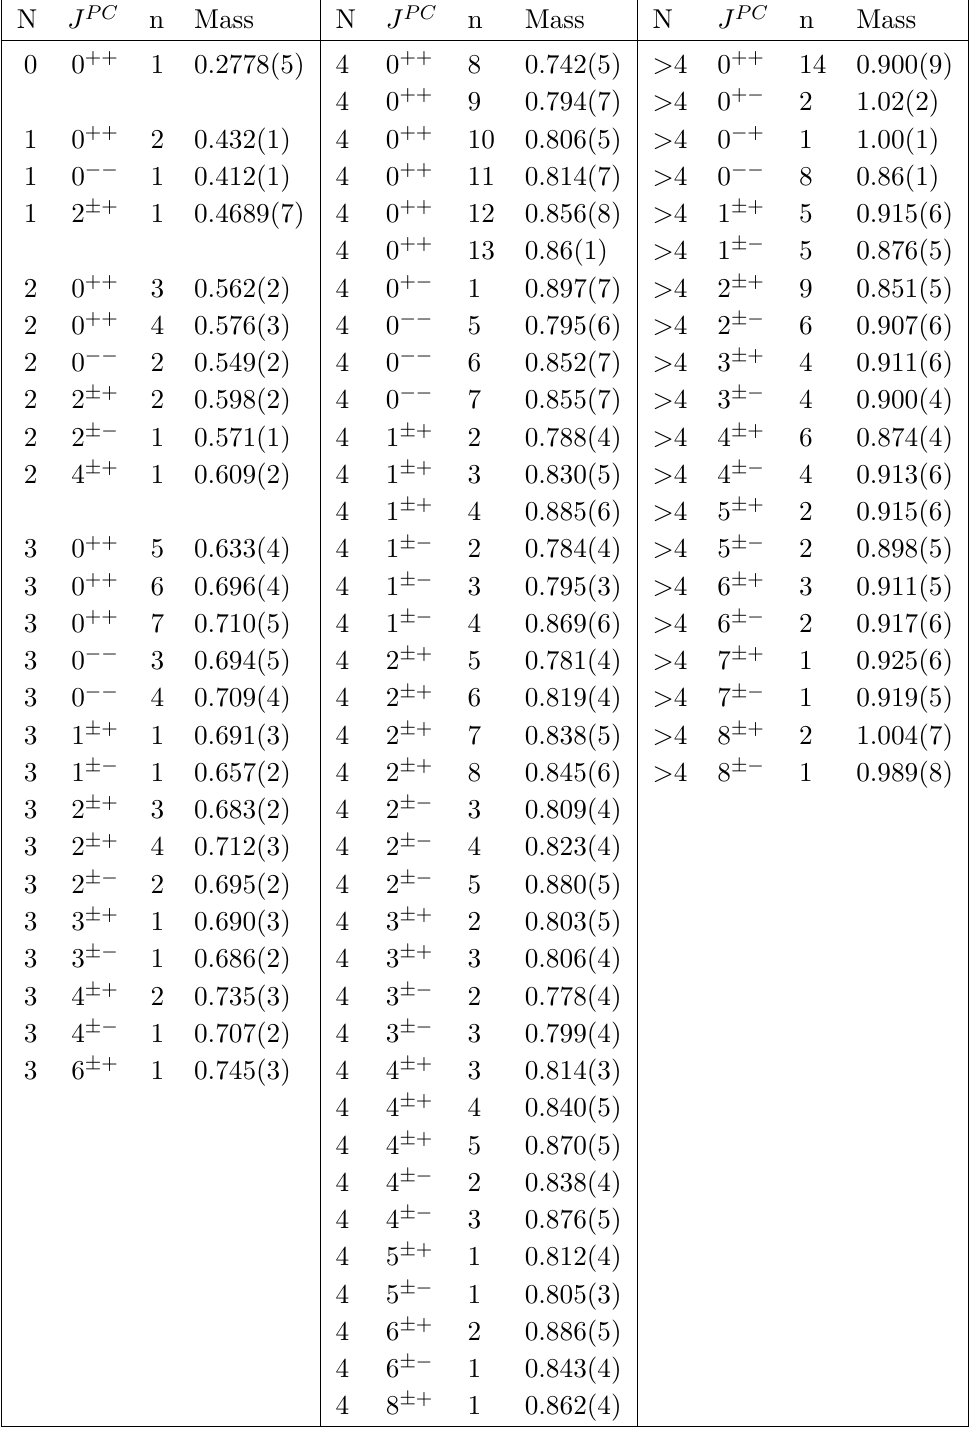
Table 10. Glueball masses for AR operators organized by N. Masses averaged over P for J >